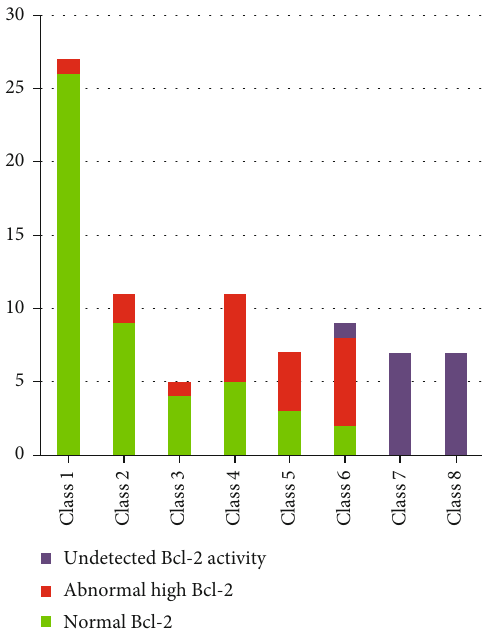
Figure 3: Distributions of patients according to cytometry classes vs. Bcl-2 activity.